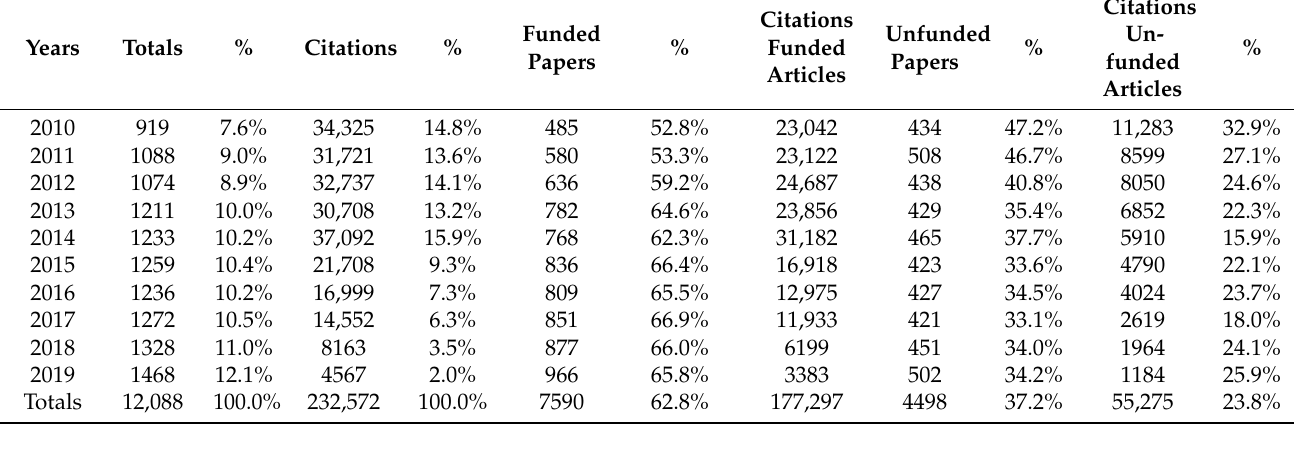
Table 1. Annual evolution of papers and citations.